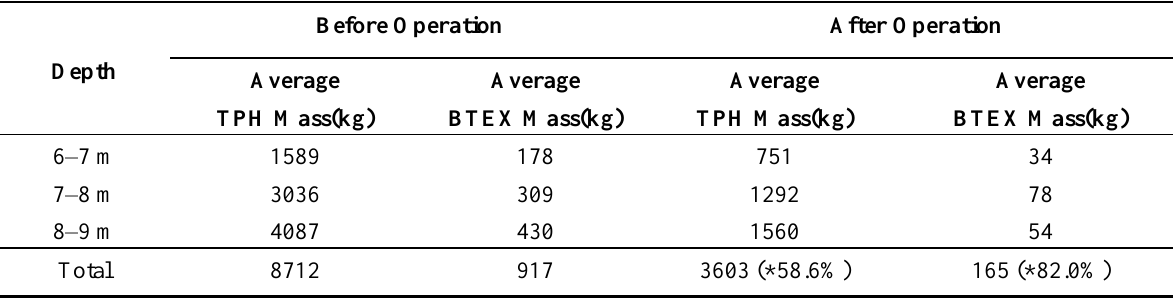
Table 5. TPH and BTEX mass removed during full scale operation at a petroleum polluted military